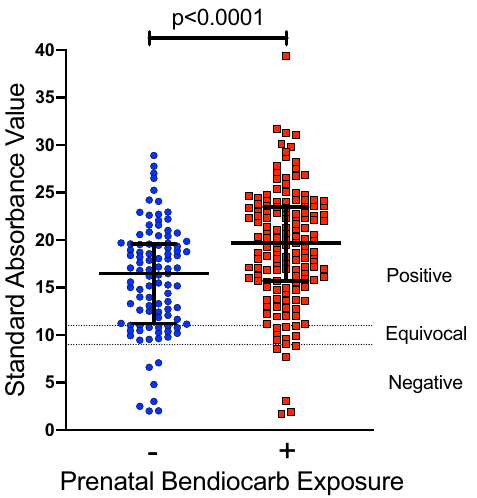
Fig. 4 Prenatal bendiocarb exposure is associated with higher post- vaccination levels of measles-speci fi c IgG. Measles-speci fi c IgG levels at 1 year of age among infants prenatally exposed to bendiocarb (exposed, red, n = 149 and unexposed, blue, n = 99, p < 0.0001, ran in duplicate). Dotted lines indicate control thresholds (Wilcoxon rank-sum test, bars indicate median with interquartile range. Two-sided p values were calculated for all test antibodies. Dendritic cell staining was performed on 238 cord blood samples using FITC Lin-2 (clone M φ P9/SJ25C1/SK7/L27/NCAM16.2, anti-CD3, CD14, CD19, CD20, CD56), PE CD123 (clone 9F5), PerCP HLA-DR (clone L243), and APC CD11c (clone S-HCL-3, BD Pharmingen). Cells were immediately analyzed on an Accuri A6 cytometer. Dendritic cells were de fi ned as Lin-2 − HLA-DR + , myeloid dendritic cells were de fi ned as Lin-2 − HLA- DR + CD11c + CD123 − , and plasma-